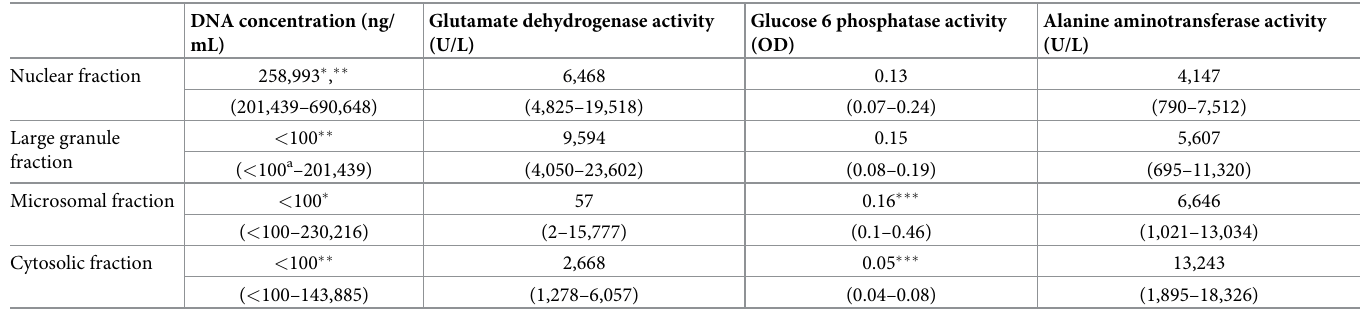
Table 2. Summary of the DNA and enzymatic activity assays in four liver fractions from five frozen cat liver specimens. DNA concentration (ng/